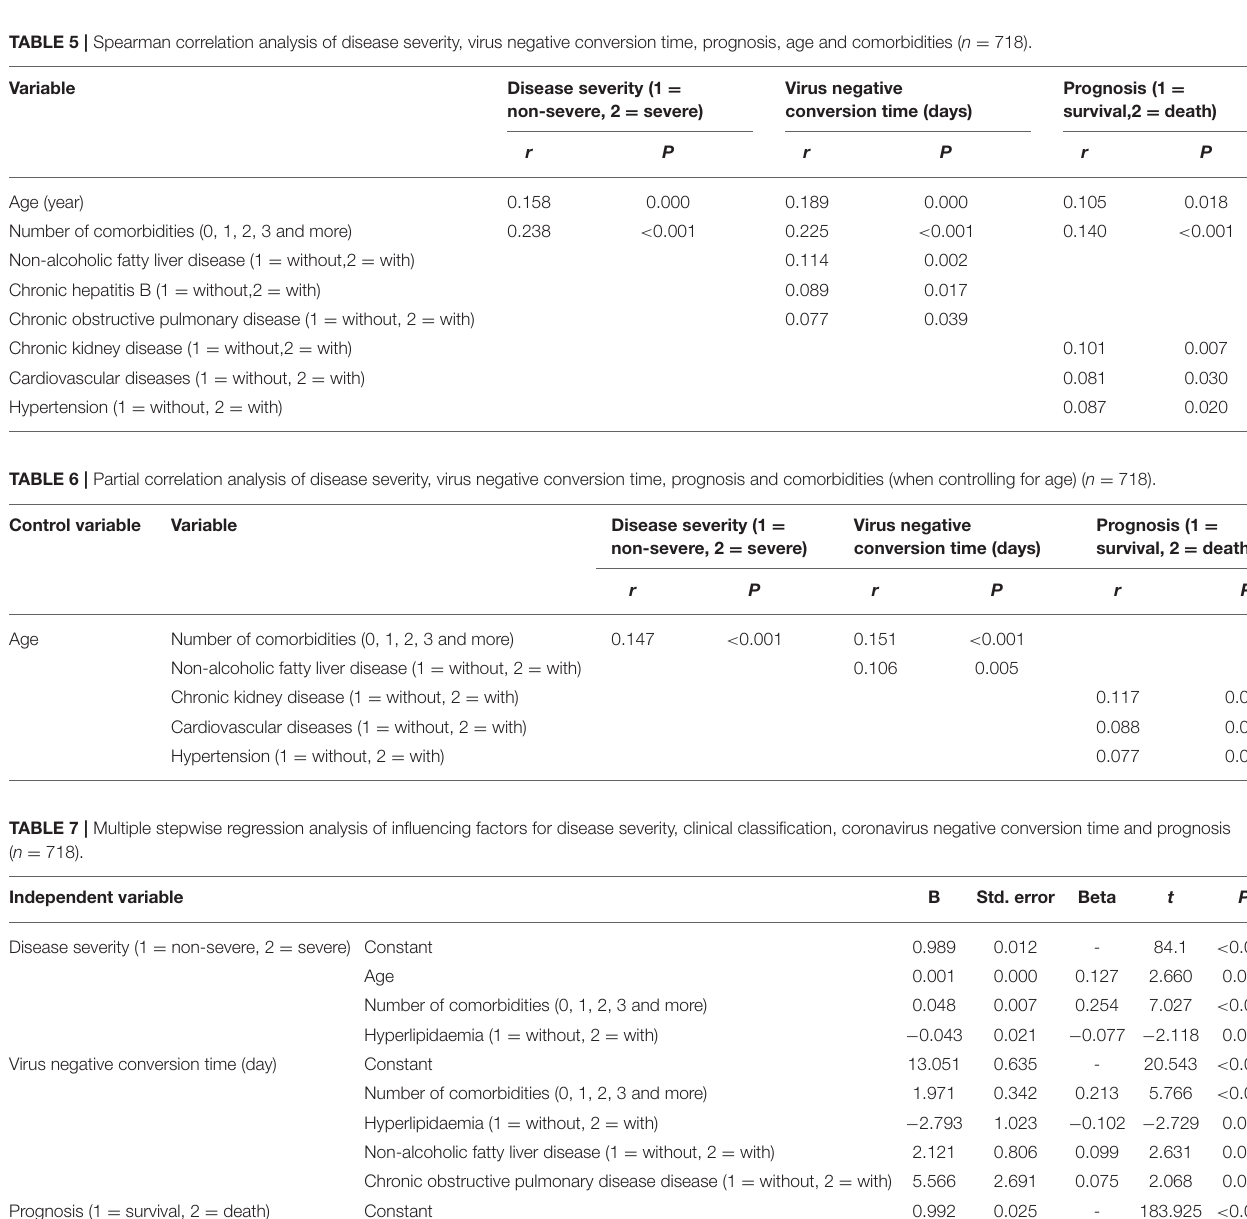
TABLE 8 | The performance of various methods for distinguishing between the severe cases and the non-severe patients( n = 718). Variables